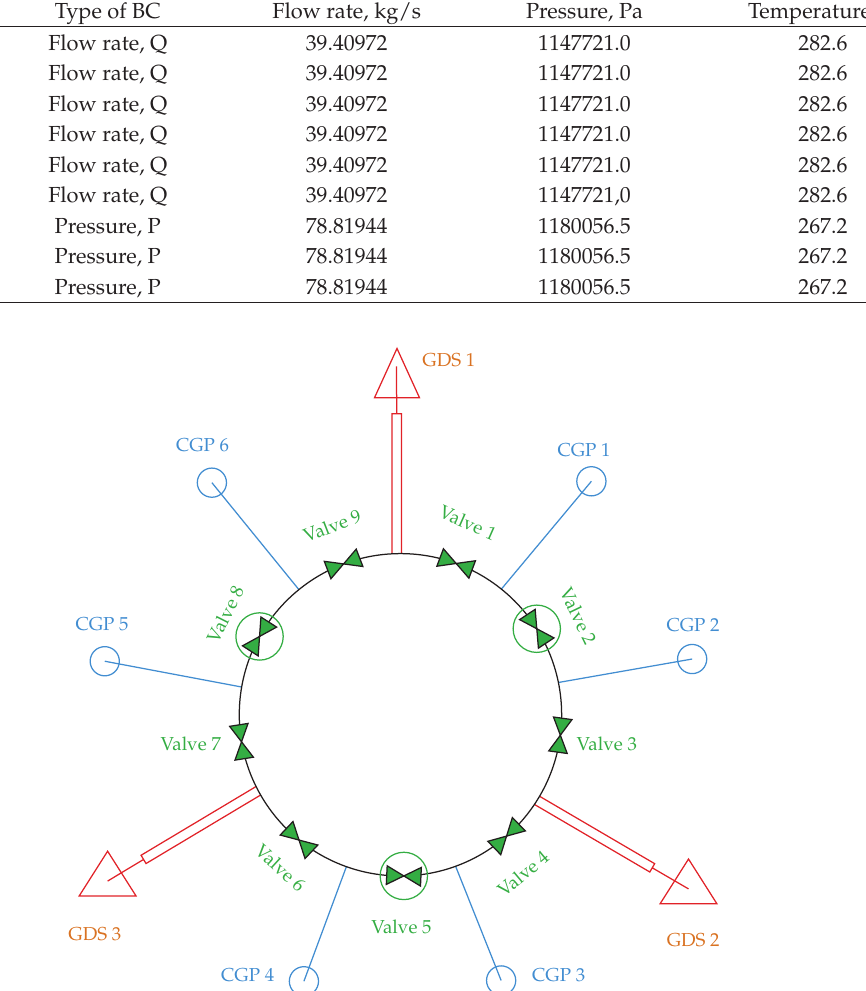
Figure 4: A diagram of identification points placement (cid:5) triangles indicate flow rate monitoring points, circles indicate pressure monitoring points (cid:6)